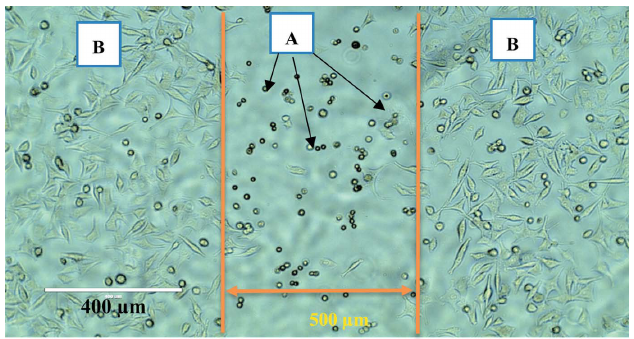
Figure 16 Morphological changes in MM418 cells 24 h after they were irradiated with 1000 Gy. The area enclosed between orange lines is exposed to 90 kVp SBB. (A) Apoptotic cells in irradiated area. (B) Viable cells in unirradiated area.